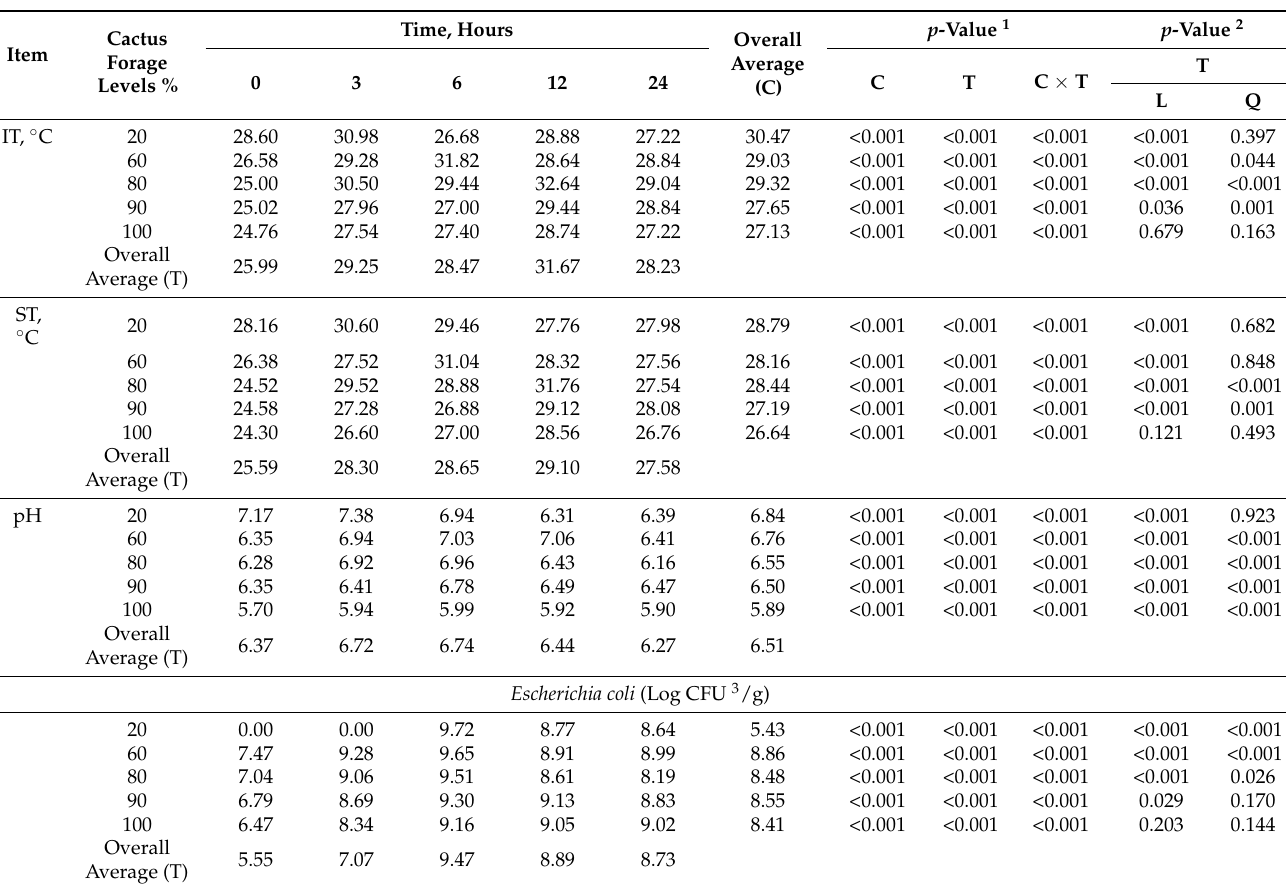
Table 2. Mean values of internal temperature (IT), surface temperature (ST), potential of hydrogen (pH), and Escherichia coli population as a function of cactus forage levels and time of exposure to air.